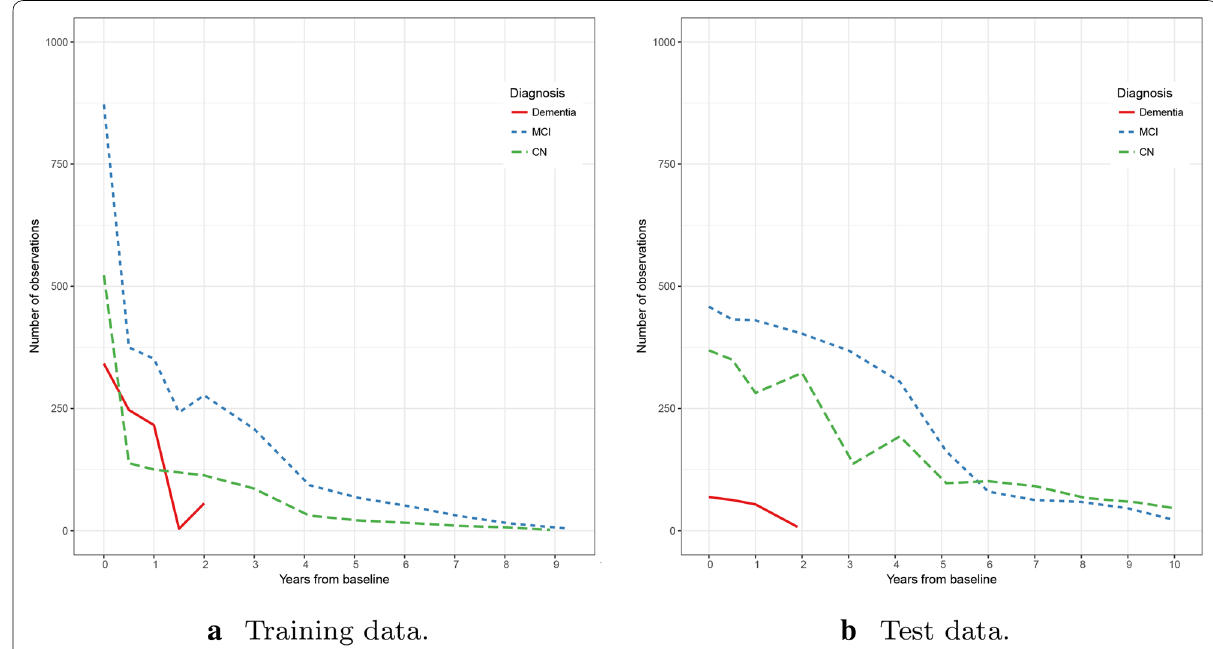
Fig. 7 Number of individuals observed at each visit by initial diagnosis. CN Control, MCI mild cognitive impairment